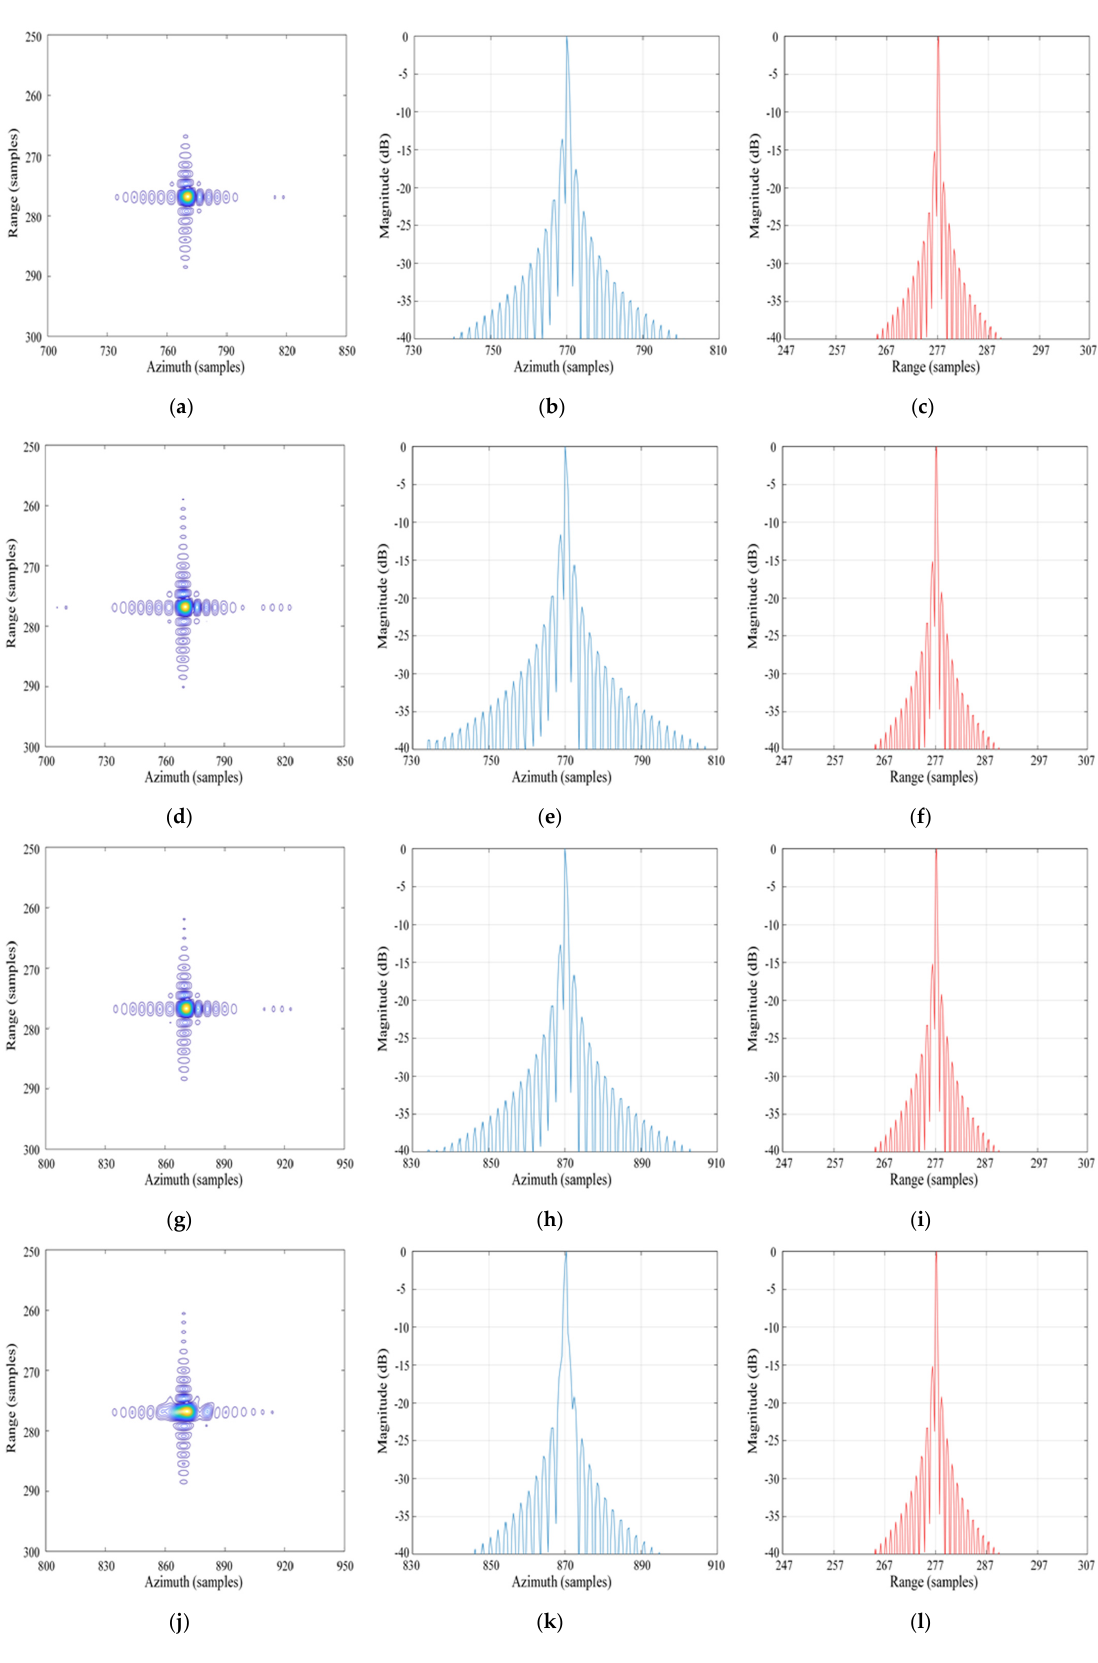
Figure 9. Imaging results of T 1 , T 3 , and T 5 points using the imaging algorithm. ( a ) The proposed algorithm; ( b ) the traditional algorithm.